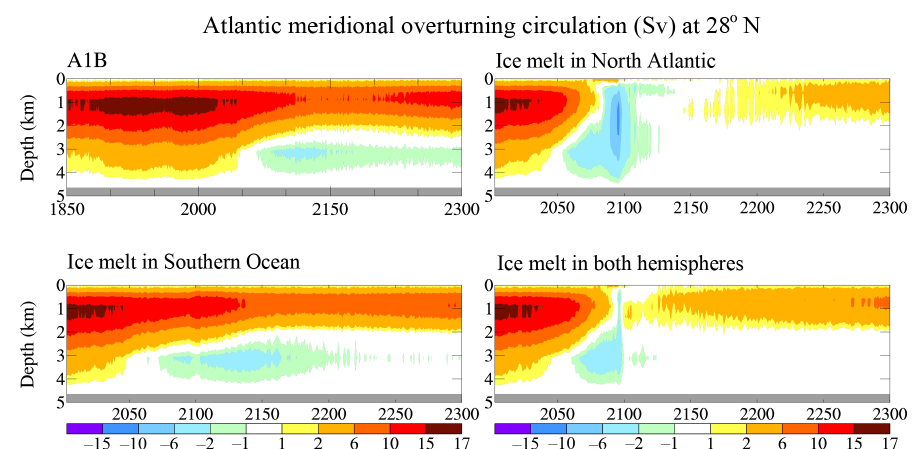
Figure 9. Ensemble-mean AMOC (Sv) at 28 ◦ N versus time for the same four scenarios as in Fig. 6, with ice melt reaching 5m at the end of the 21st century in the three experiments with ice